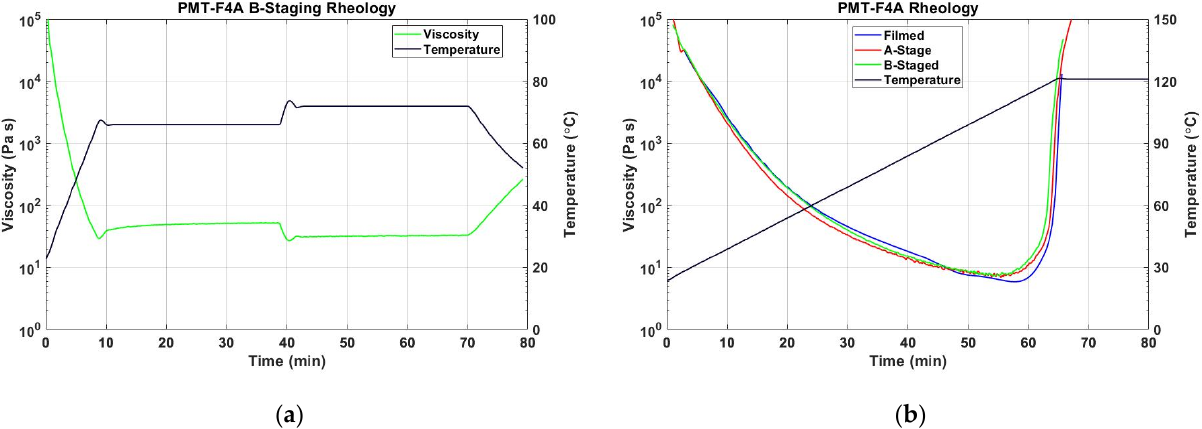
Figure 1. ( a ) Rheological profile for PMT-F4A following the filming process thermal cycle. ( b ) Rheological profiles for three separate samples of PMT-F4A.